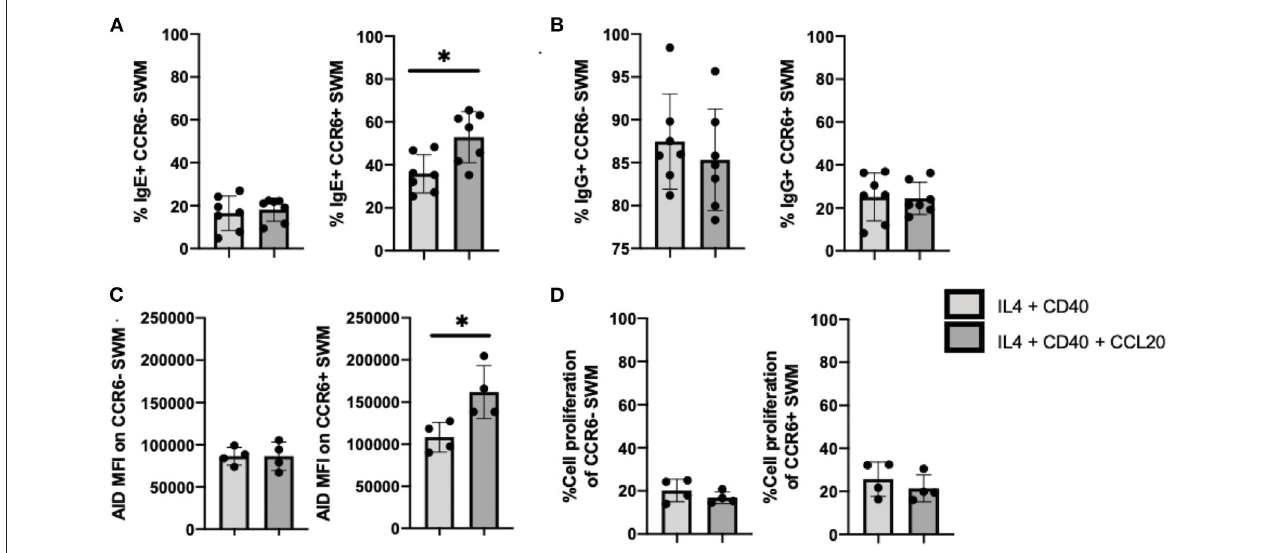
FIGURE 5 | CCL20/CCR6 intrinsic signaling augments IgE isotype switching through induction of AID expression. (A) Percentage of IgE + of CCR6- SWM and CCR6 + SWM after 10 days culture with 20ng/mL IL-4, 10 ug/mL anti-CD40 ± 20ng/mL CCL20. (B) Percentage of IgG + of CCR6- SWM and CCR6 + SWM after 10 days culture with 20ng/mL IL-4, 10 ug/mL anti-CD40 ± 20ng/mL CCL20. (C) Expression of AID measured by MFI on CCR6- SWM and CCR6 + SWM after 3 days culture with 20ng/mL IL-4, 10 ug/mL anti-CD40 ± 20ng/mL CCL20. (D) Percentage of cell proliferation measured by cell-trace violet of CCR6- SWM and CCR6 + SWM after 3 days culture with 20ng/mL IL-4, 10 ug/mL anti-CD40 ± 20ng/mL CCL20. * p < 0.05 by Mann-Whitney